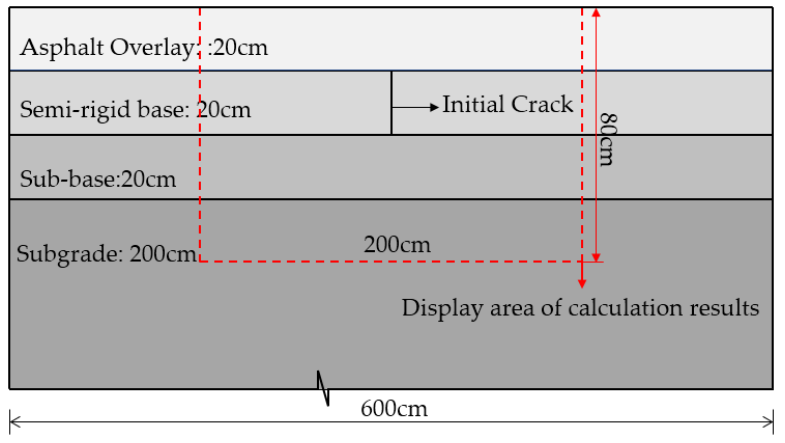
Figure 9. Pavement model.